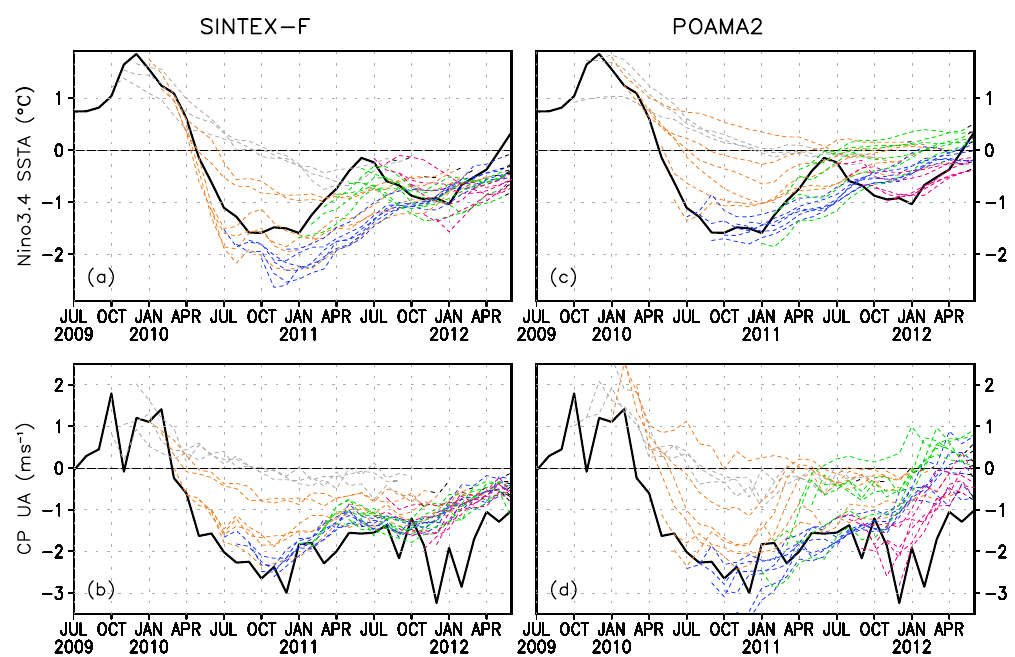
Figure 2. Two-year hindcasts of the La Niña in 2010–12 produced by the two global ocean-atmosphere coupled models. The black lines in ( a,c ) and ( b,d ) indicate the observed SST anomalies in Nino3.4 region and the zonal wind anomalies in the central Pacific Ocean, respectively. The dashed colour lines display plumes of the models’ two-year hindcasts of the SST and wind anomalies, which are initiated from every month during October 2009-December 2011 (see Methods). Results of the SINTEX-F and POAMA2 are based on 9 and 20 member ensemble mean hindcasts, respectively. The model hindcast anomalies are computed relative to the model climatology of 1983–2011 at each lead time. This figure is created using Grid Analysis and Display System (GrADS) Version 2.0.2